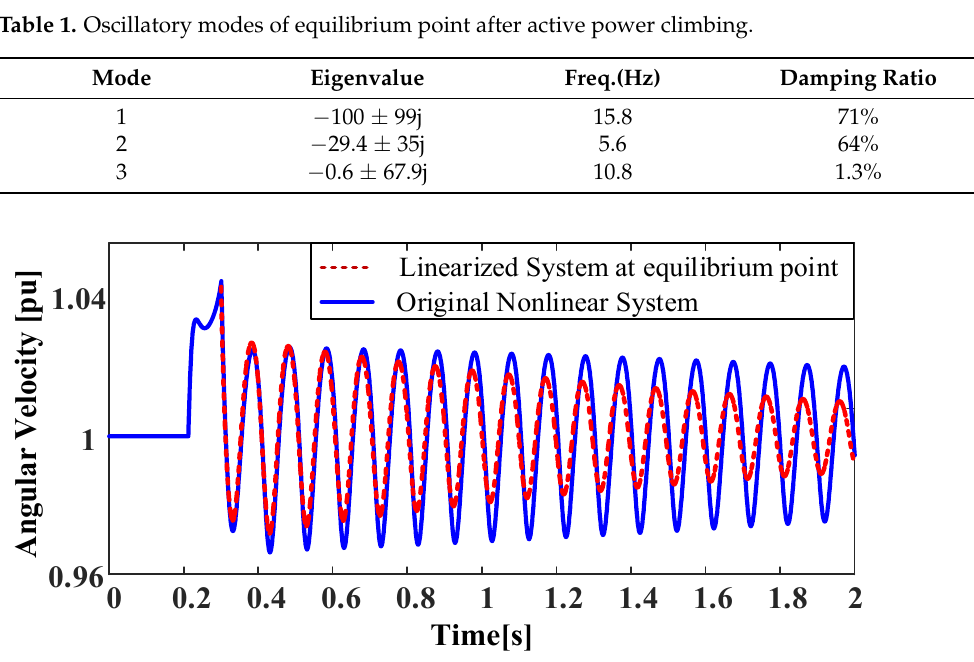
Figure 14. Comparative simulated results of internal voltage’s angular velocity between original nonlinear system and linearized system at equilibrium point. Since damping ratios of modes one and two are large, the oscillation component dominated by them will attenuate quickly, and the obtained simulated responses can